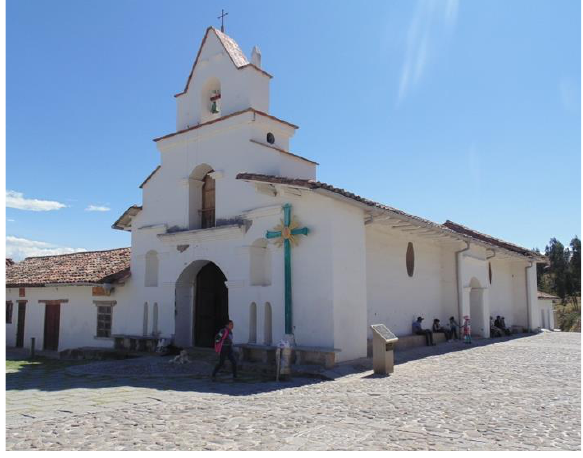
Figure 1. The chapel of Susudel Source: Barsallo,